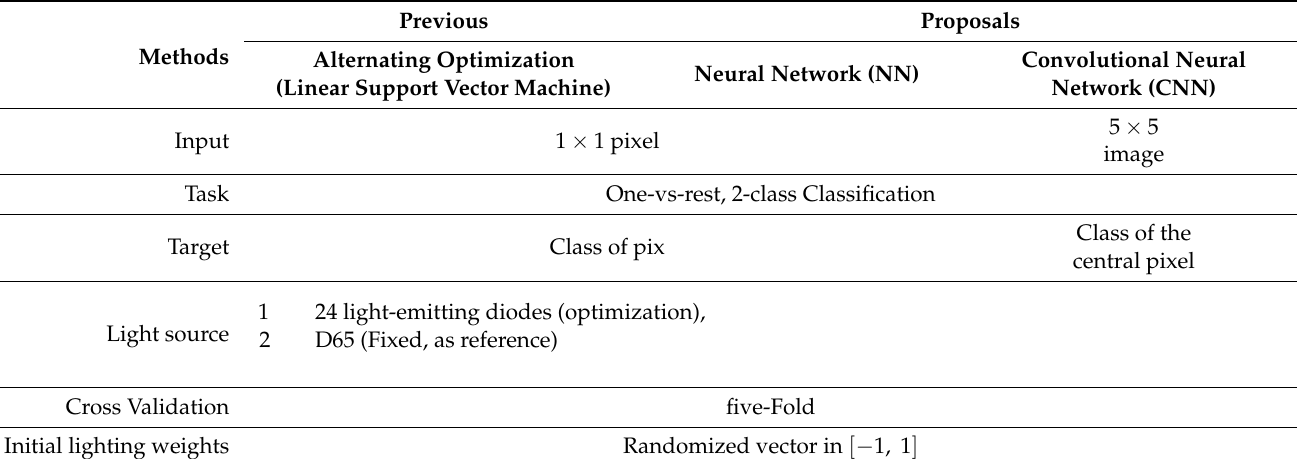
Table 1. Conditions of a classification